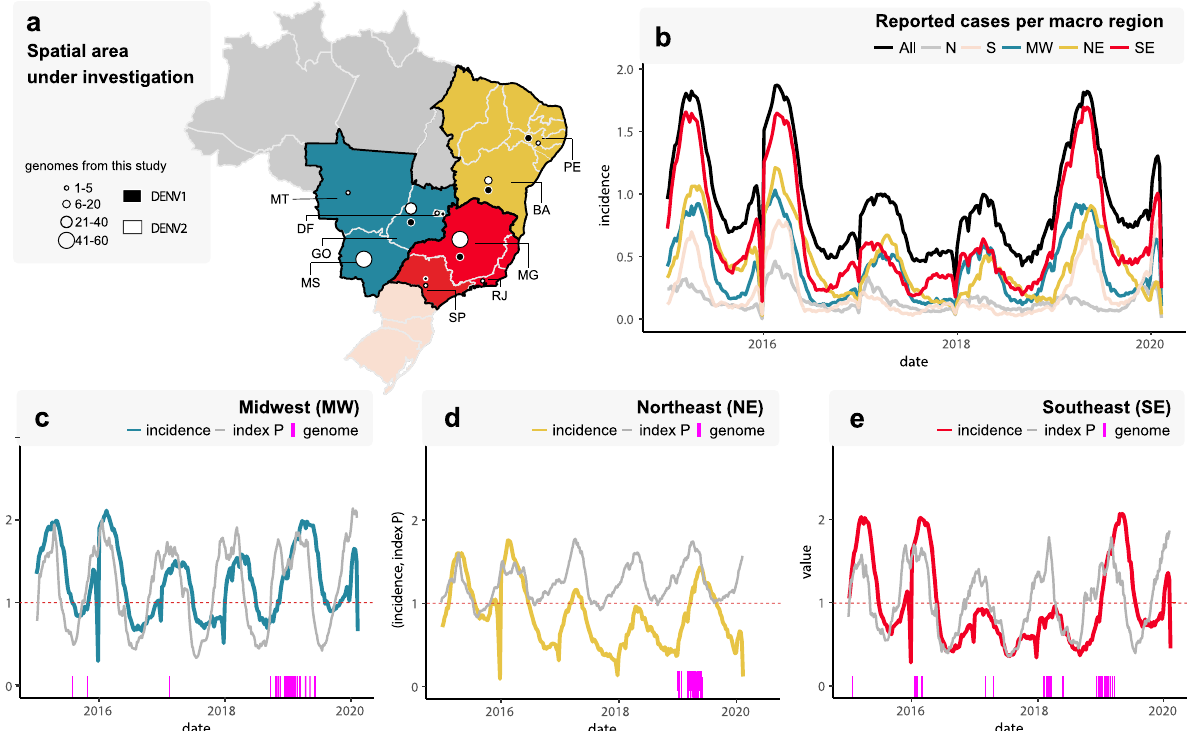
Fig. 1 Spatial and temporal distribution of reported dengue cases in Brazil, 2015 – 2020. a Map of Brazil showing the number of DENV1 and DENV2 new sequences by region and state. DF = Federal District, BA = Bahia state, GO = Goiás state, MT = Mato Grosso state, MS = Mato Grosso do Sul state, MG = Minas Gerais state, PE = Pernambuco state, RJ = Rio de Janeiro state, SP = São Paulo state. The color and size of the circles indicates the number of new genomes generated in this study (black = DENV1, white = DENV2). b Weekly noti fi ed dengue cases normalized per 100 K individuals per region in 2015-2020 (until EW06). Epidemic curves are colored according to geographical macro region: SE = Southeast, NE = Northeast, MW = Midwest, N = North, S = South. c – e Time series of weekly reported cases normalized per 100 K individuals and daily mosquito-viral suitability measure (index P) in the three macro regions for which new sequences were generated: MW = Midwest (C), NE = Northeast (D), and SE = Southeast (E). The index P of each region is obtained using average climatic data for the three largest urban centers in each region. Purple bars highlight the dates of sample collection of the genomes generated here. b – e Incidence (cases per 100 K population) is presented in log10 for visual purposes. The initial map of Brazilian regions was obtained from the R package “ get_brmap ” (available at: https://rdrr.io/cran/brazilmaps/man/get_brmap.html). Source data are provided as a Source Data fi